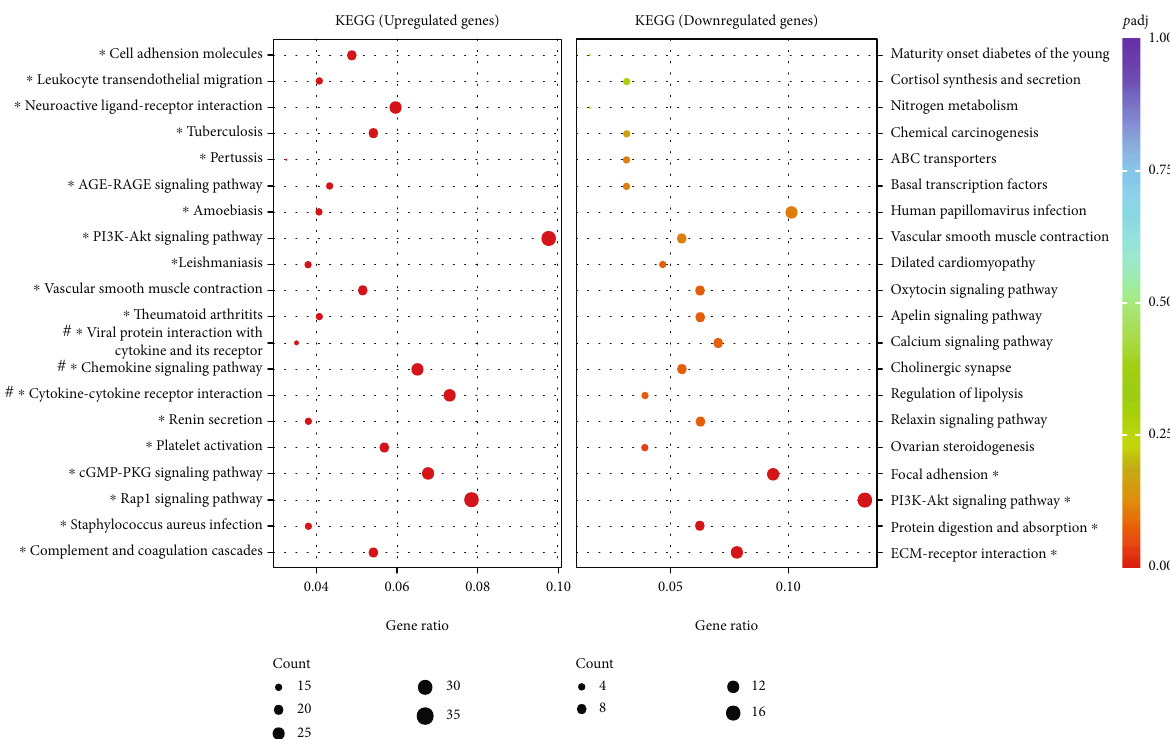
Figure 3: KEGG analysis found that di ff erentially expressed genes were signi fi cantly enriched in many pathways, including PI3K-Akt pathway, Rapl signaling pathway, and chemokine signaling pathway. CX3CL1 was involved in chemokine signaling pathway. Only top 20 enriched pathways were presented for upregulated genes and down regulated genes, respectively. “ ∗ ” indicates a p : adj < 0 : 05 . “ # ” indicates that CX3CL1 was involved in the